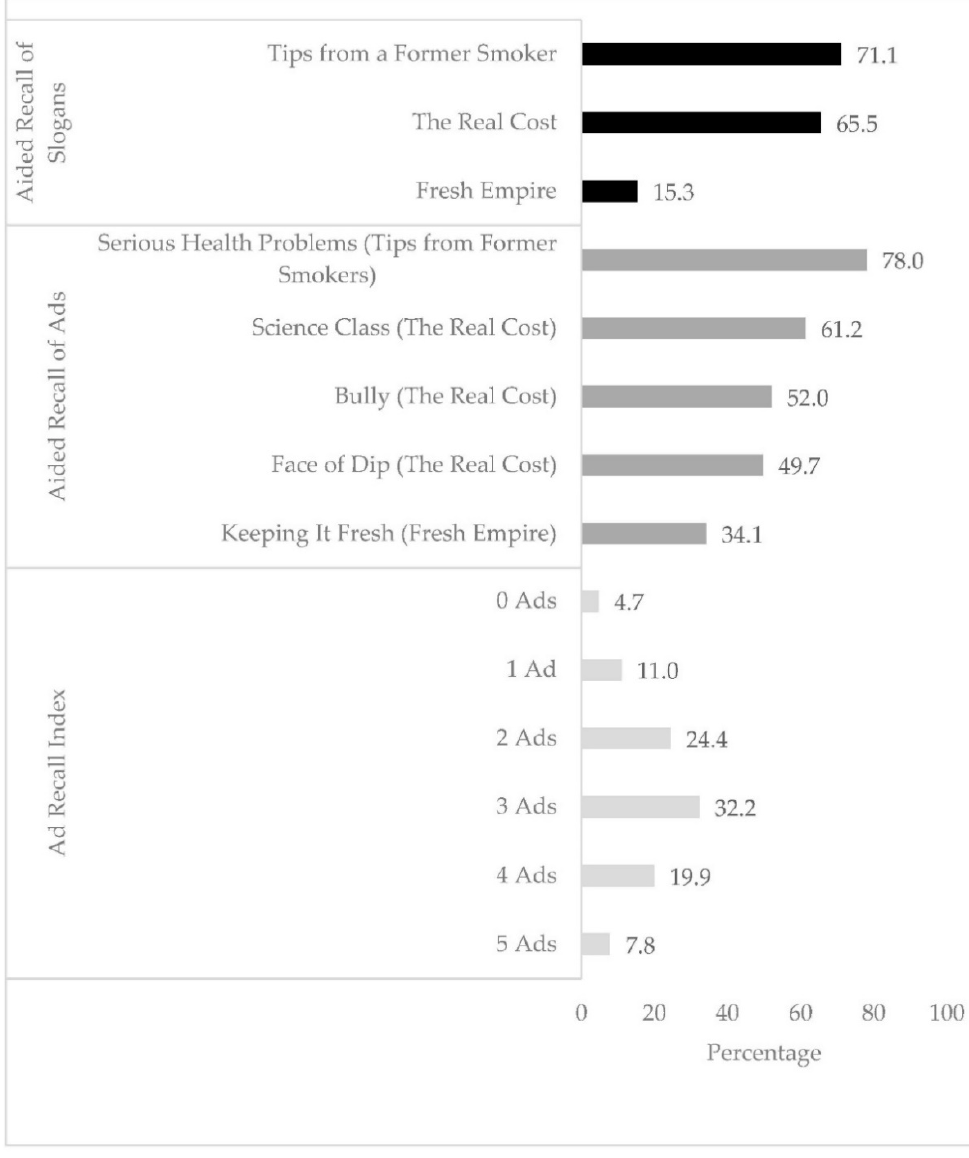
Figure 1. Frequencies of aided recall to slogans, ads, and ad index from a national sample of adolescents, conducted by the Survey Research Laboratory from August 2016 to May 2017.